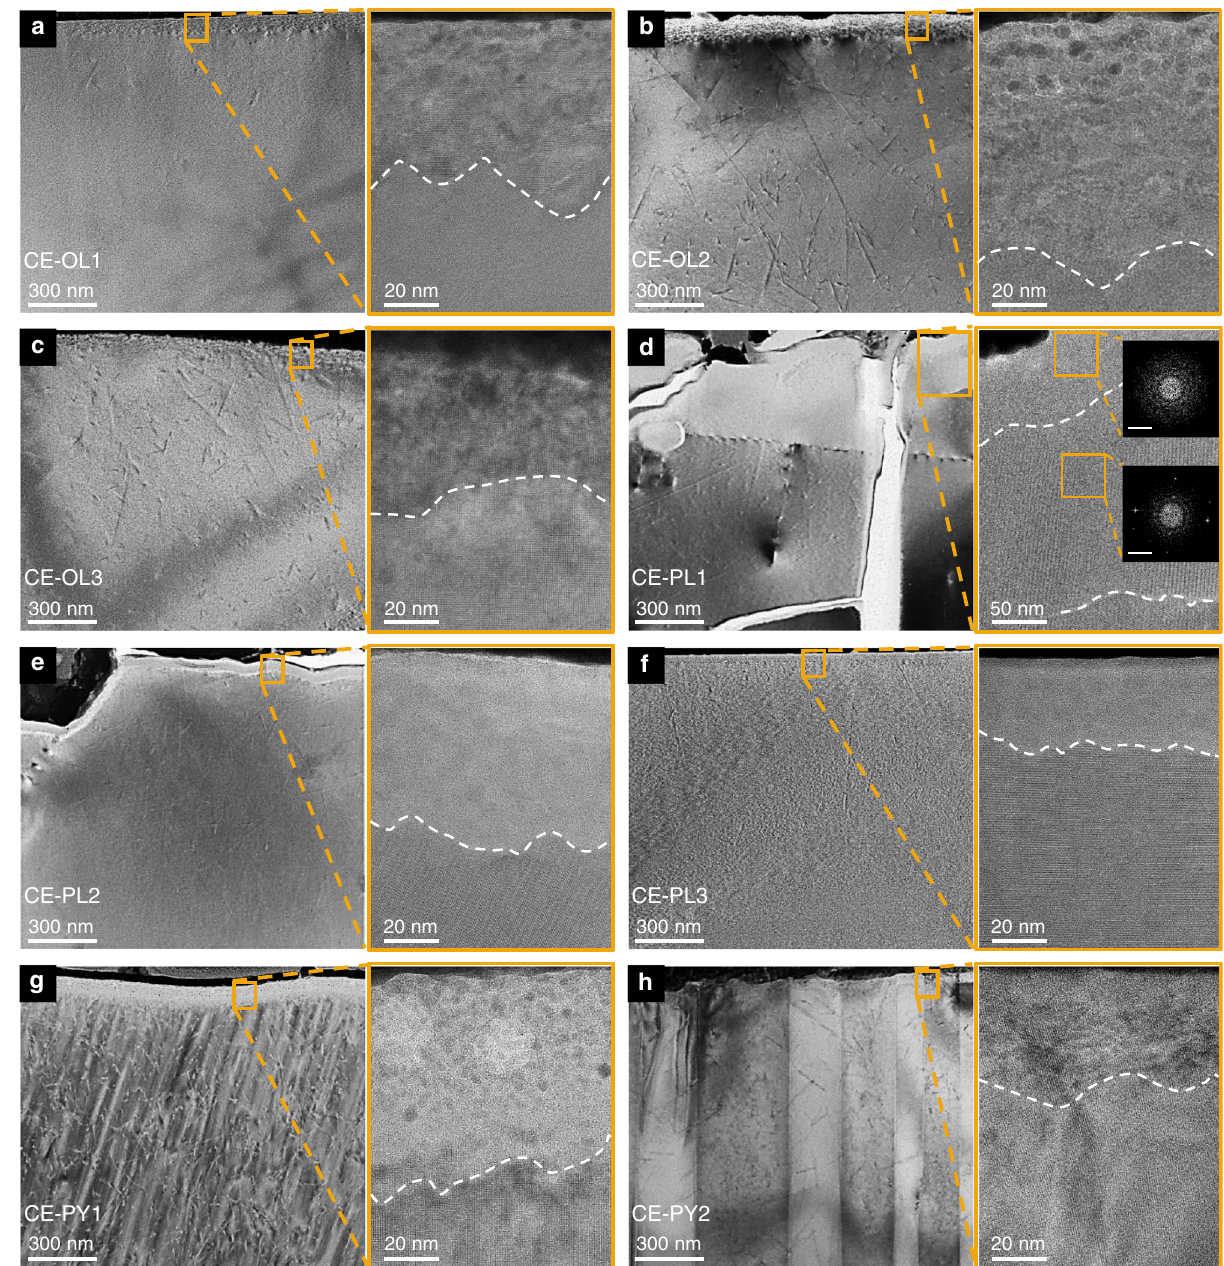
Fig. 2 | Characteristics of lunar grain surfaces. a – c TEM bright- fi eld images of olivine samples a CE-OL1, b CE-OL2, and c CE-OL3. d – f TEM bright- fi eld images of plagioclase samples d CE-PL1, e CE-PL2, and f CE-PL3. g , h TEM bright- fi eld images of pyroxene samples g CE-PY1 and h CE-PY2. For each group of images, the image ontherightisamagni fi edviewoftheorangeboxwiththedashedborderintheleft panel;thescalebaroftheleftimageis300nm,andthescalebaroftherightimage is 20nm, except for ( d ) for which the scaleof the right imageis50nm.Inthe right